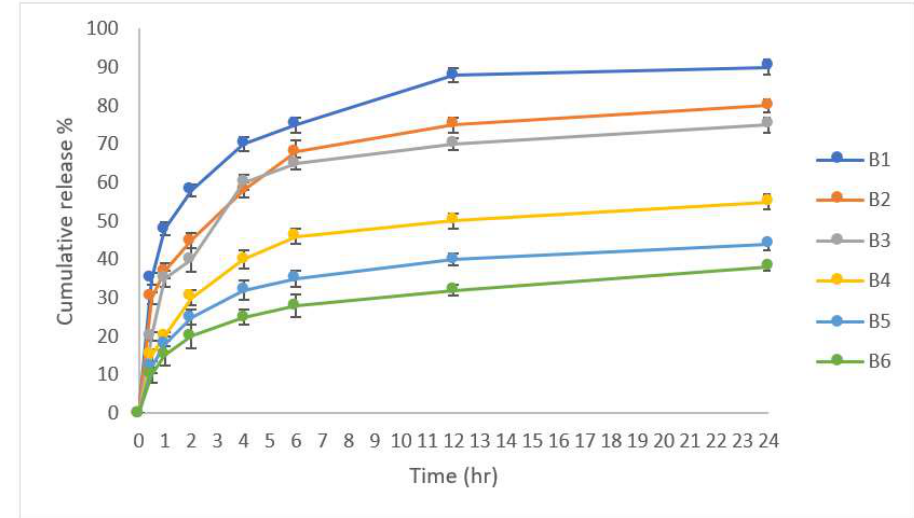
Figure 5. In vitro drug release data of the prepared tablets ( n =